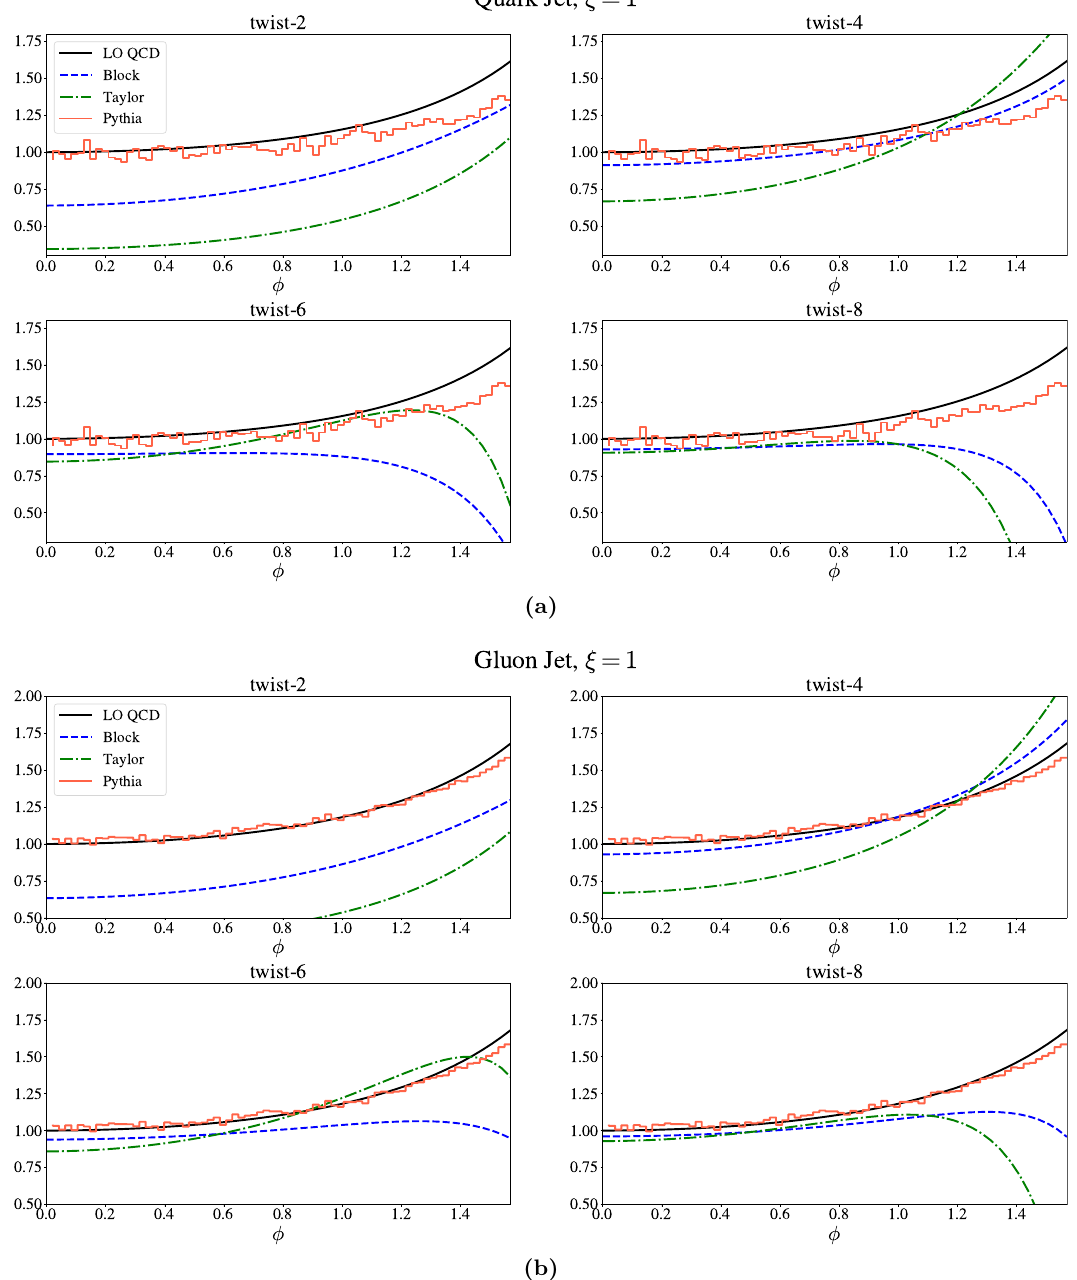
Figure 16. A slice of the leading order three-point correlator at ξ = 1 . 0 for quark jets in (a) and gluon jets in (b). We compare the full QCD result, the expansion in celestial blocks, the naive Taylor expansion, and the result from Pythia. This slice contains the equilateral triangle configuration at φ = π/ 2 , which is far from the OPE limit. We observe poor convergence of the expansion in this